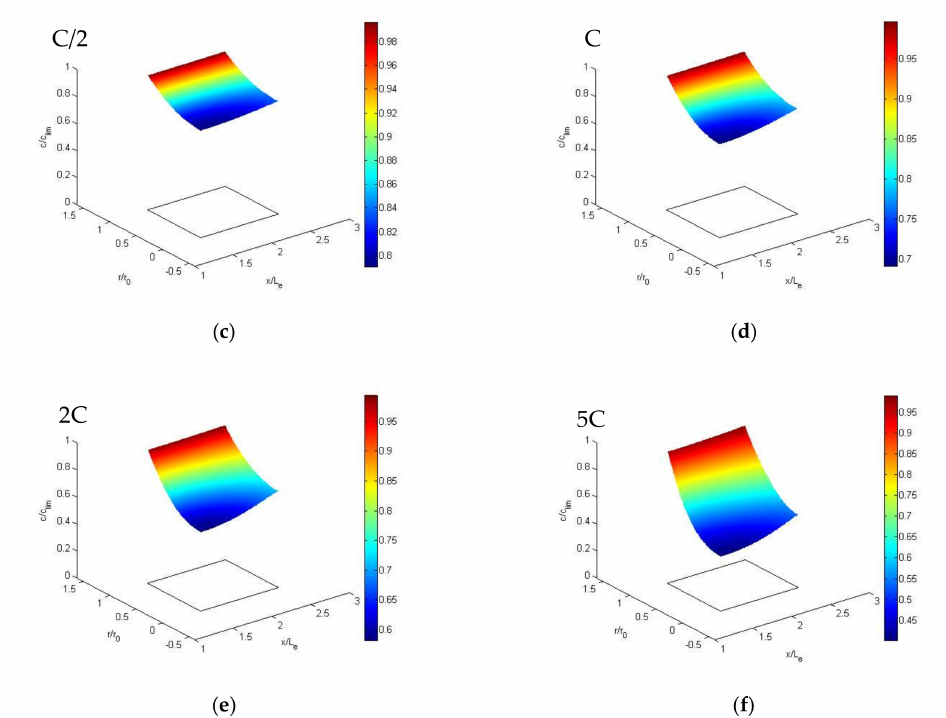
Figure 8. The profiles of the dimensionless concentration of lithium over the cathode thickness ( L e ) and the particle radius ( r 0 ) for di ff erent discharge rates: 0.1C ( a ), 0.2C ( b ), 0.5C ( c ), 1C ( d ), 2C ( e ), 5C ( f